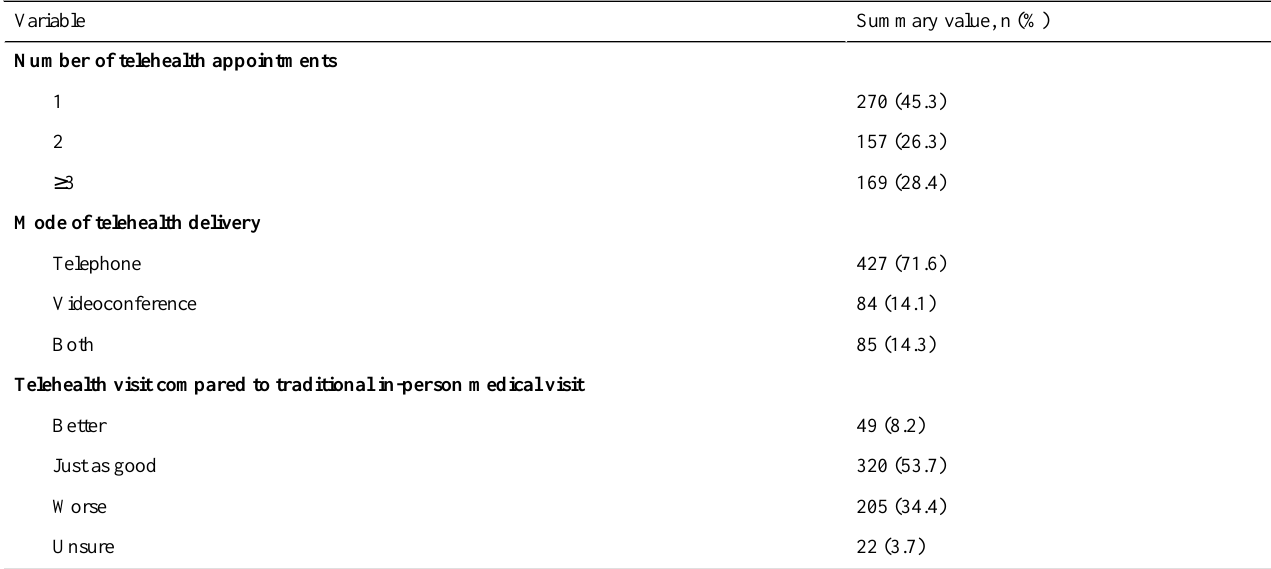
Table 2. Characteristics of telehealth users’experience